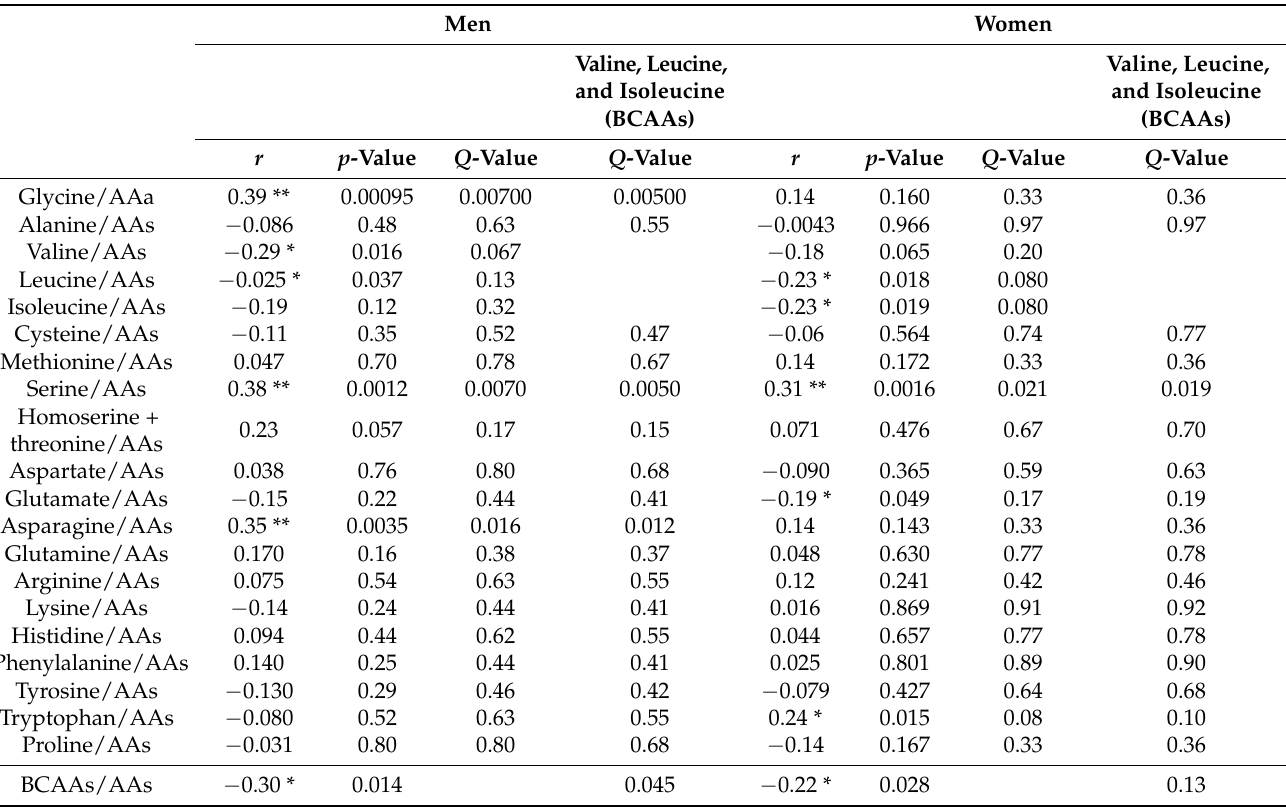
Table 2. Correlation between amino acid concentrations and total hemoglobin concentration in the supraclavicular region. Men